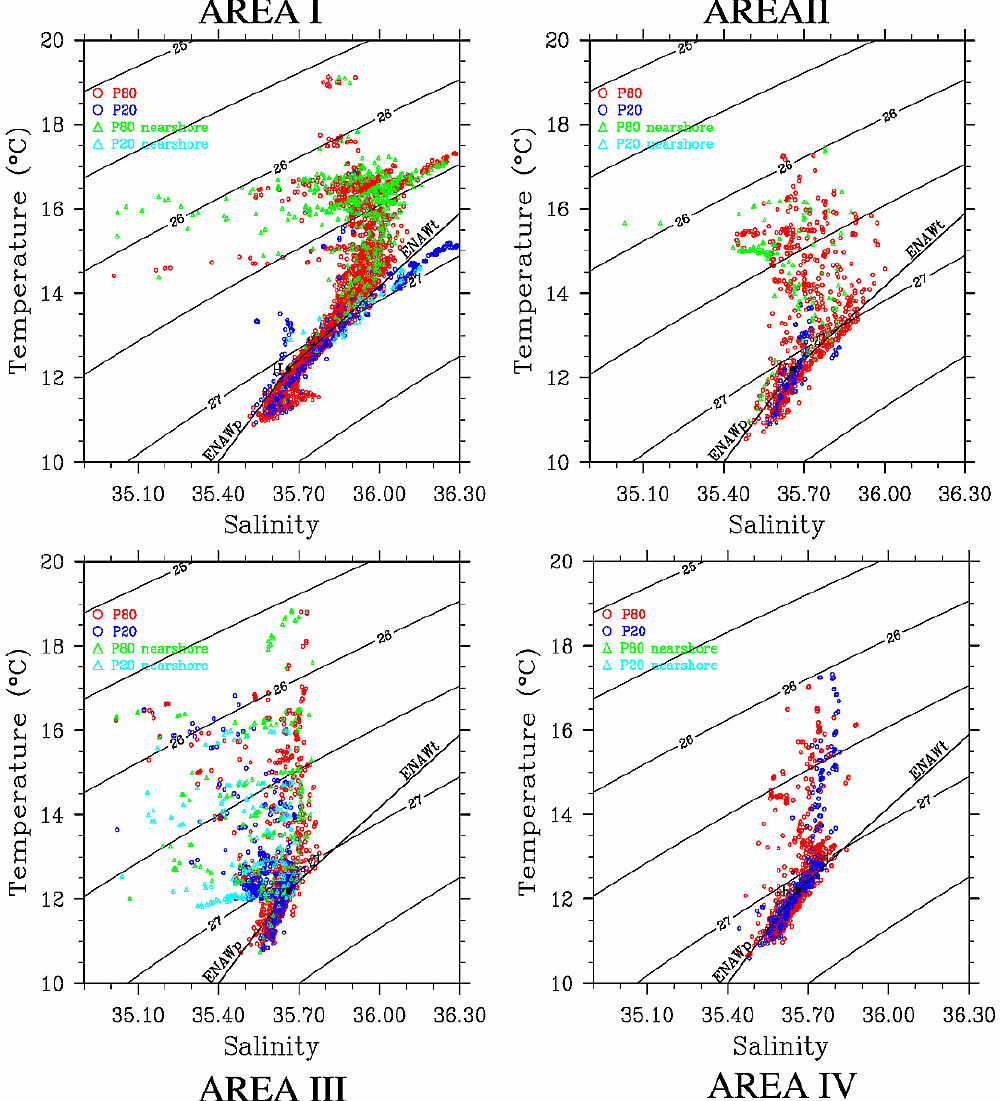
Fig. 9. As Fig. 8 but for the T/S diagrams instead of the vertical profiles (also including the 300–500m depth range). The profiles related to shallow ( < 200m, triangles) and deeper waters (circles) are plotted separately, so that the red and green markers are related to the P80 set and the dark and light blue ones to the P20 set. ENAW P and ENAW T definition lines, and also their crossing point ( H ), are